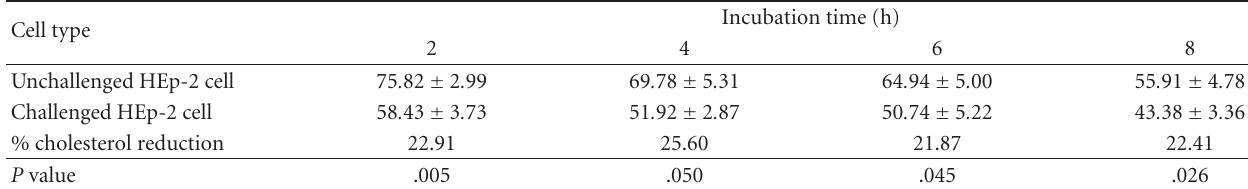
Table 4: Cholesterol quantification [( μ g/10 5 cells) ± SD] in uninfected and infected HEp-2 cell